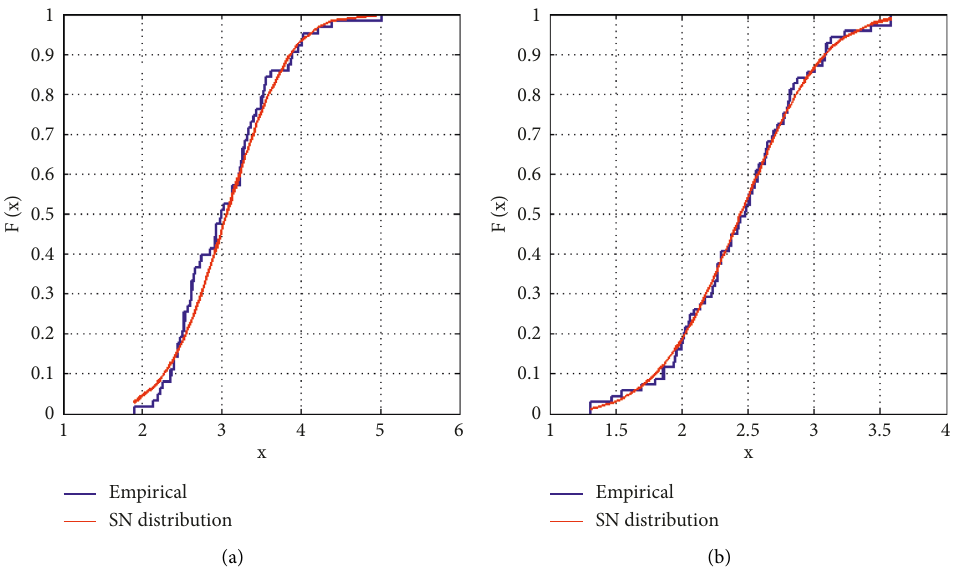
Figure 5: Empirical CDF plots of SN distributions for datasets. (a) Dataset I. (b) Dataset II.